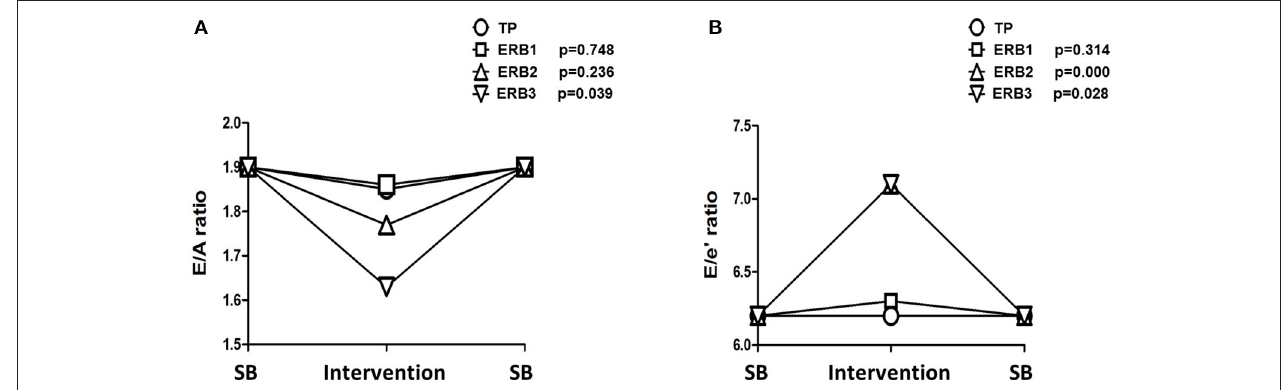
FIGURE 2 | Line chart of changes in E/A (A) and E/e’ (B) during tachypnea and expiratory resistance breathing with diameters of 3mm (ERB1), 2mm (ERB2), and 1.5mm (ERB3). TP, tachypnea; ERB, expiratory resistance breathing; SB, spontaneous breathing.